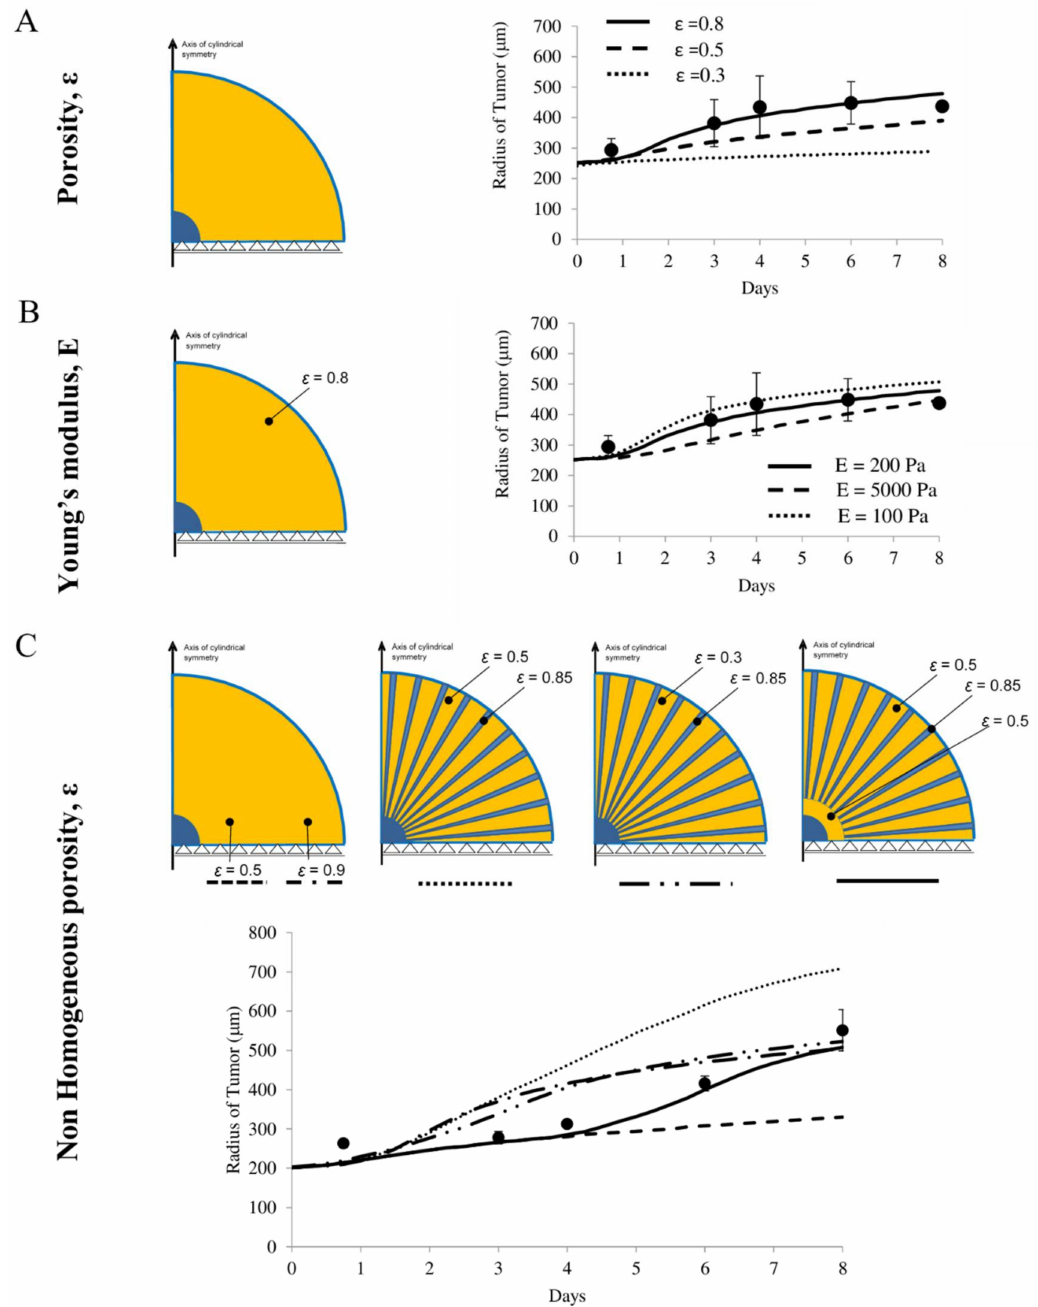
Figure 10. Computational model predictions for tumor spheroid growth. ( A ) Tumor core radius variation over time for di ff erent ECM porosity conditions, ranging from high porosity ( ε = 0.8) to low porosity ( ε = 0.3). ECM properties are homogenous across the domain, externally to the central blue core. ( B ) Tumor core radius variation over time for di ff erent ECM Young’s moduli E , ranging from a soft ( E = 100 Pa) to a rigid ( E = 5000 Pa) situation, for a constant porosity ε = 0.8. ECM properties are homogenous across the domain, externally to the central blue core. ( C ) Tumor core radius variation over time for di ff erent spatial organizations of the ECM porosity, namely uniform (left schematic), nonuniform with alternating radial sectors of di ff erent porosities (two middle schematics), and a combination of the previous two configurations (right schematic). The legend for the graph lines is given under the corresponding images. In the graph, continuous lines show numerical results, dots report the average values of the experimental tests (the error bars show the standard deviation from the average